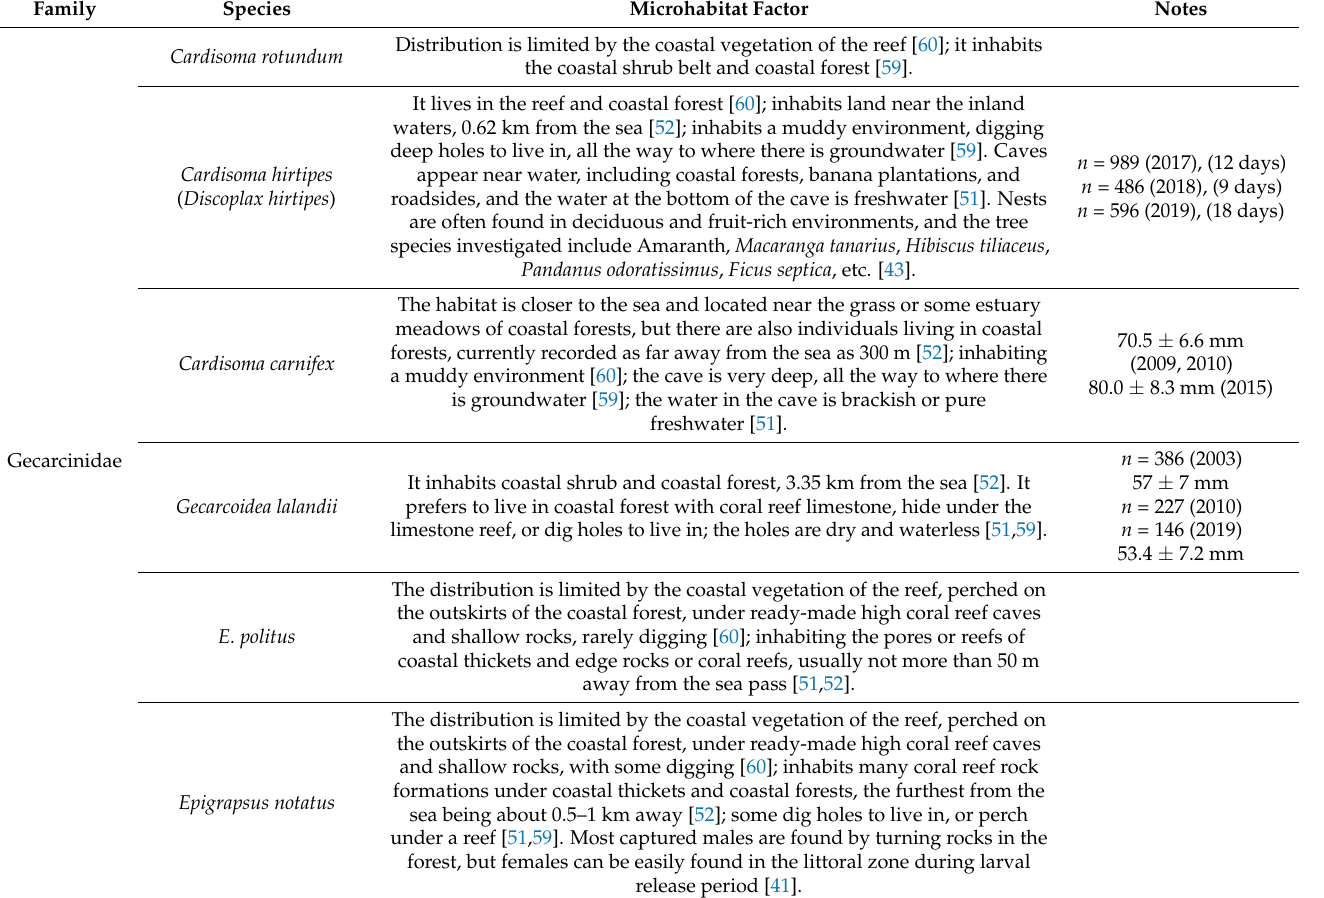
Table 2. Description data of the living environment of land